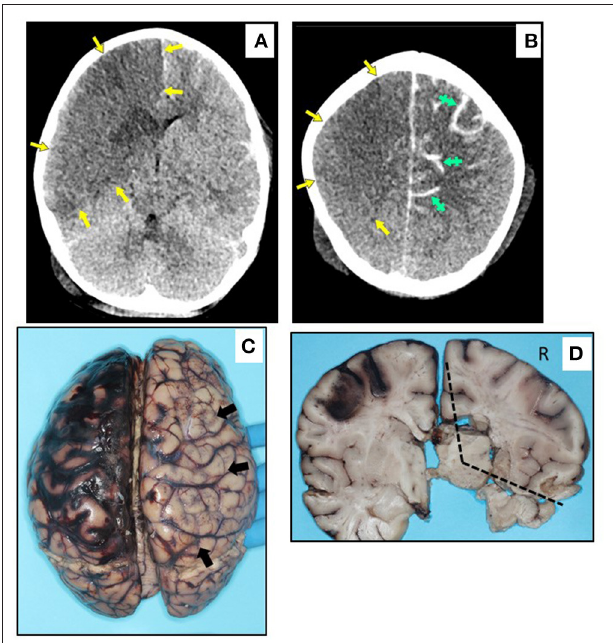
FIGURE 2 | In vivo CT imaging and macroscopic neuropathology in Case 5. (A,B) Axial non-contrast CT images, displayed in radiological orientation convention. (A) Broad area of hypodensity throughout entire right MCA and ACA distributions (yellow arrows) at level of mid-basal ganglia, reflecting cytotoxic edema in a broad area of infarction; areas of even lower density in caudate head and anterior lenticular nucleus, suggesting older or more established infarcts; minimal midline shift despite infarct volume. (B) Right MCA and ACA infarct at level of upper centrum semiovale, extending more superiorly to the vertex (yellow arrows); additional parenchymal hypodensity on left side, with increased sulcal density (green hatched arrows) reflecting diffuse subarachnoid hemorrhage. (C) Dorsal view of brain, with acute right carotid territory infarct (arrows), as well as subarachnoid hemorrhage over left hemisphere. (D) Coronal section at level of basal ganglia, showing infarct (R = right, dotted lines), and hypoperfusion of left watershed zone with reperfusion